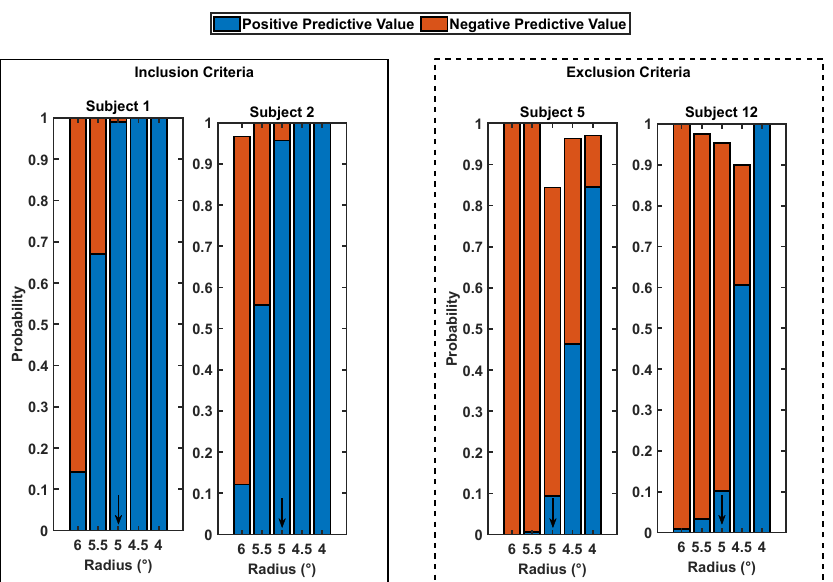
Figure 8. Inclusion and exclusion criteria for different subjects. Positive and negative predictive values were looked at to identify the trend where, irrespective of the scotoma radius, both values reached a plateau (the positive predictive value did not increase and the negative predictive value did not decrease anymore). The black arrow indicates where this plateau was reached for the majority of subjects. In this example, a demonstration is shown for subjects 1 and 2. For those where this trend was not observed, they were excluded. This was the case, for example, for subjects 5 and